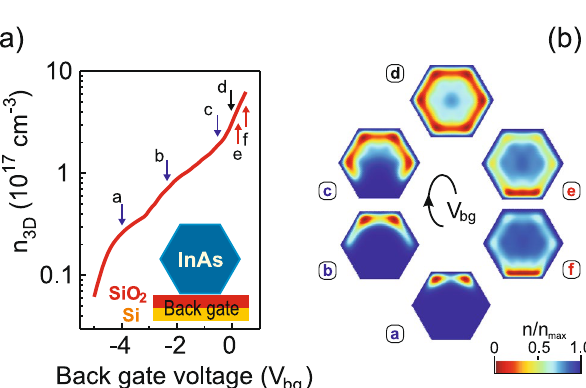
Figure 5. ( a ) Three-dimensional electron density as a function of the back-gate voltage applied to the InAs nanowire with the side length of 40 nm and the Fermi level positioned 0.16 eV above the conduction band edge at the surface at T = 4 K; the back-gate voltage is set to − 4 V (a), − 2.5 V (b), − 0.5 V (c), 0 V (d), 0.1 V (e), 0.2 V (f). Inset: Sketch of a back-gated InAs nanowire. ( b ) Two-dimensional electron distribution in the InAs nanowire corresponding to the back-gate voltage indicated